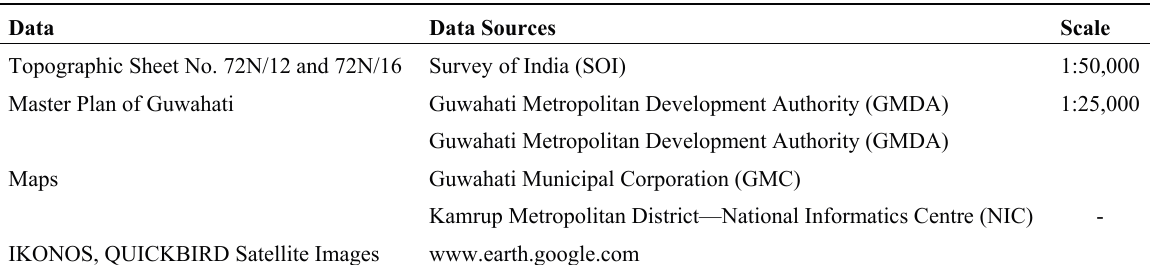
Table 2. Others data used in the study